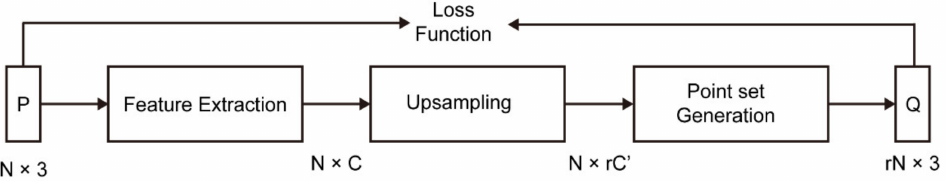
Figure 2. Schematic diagram of a point cloud upsampling model based on deep learning. C and C (cid:48) are the features of the point, r is the upsampling